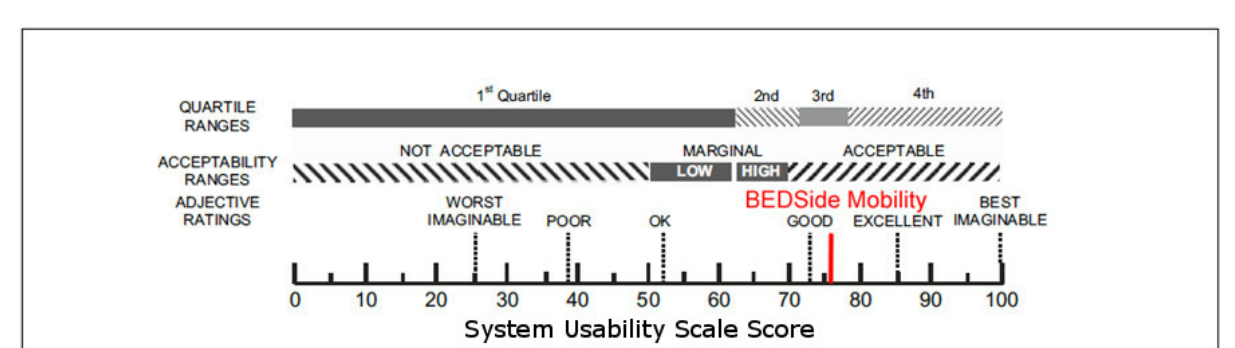
Figure 7. Adjective rating of BEDSide Mobility